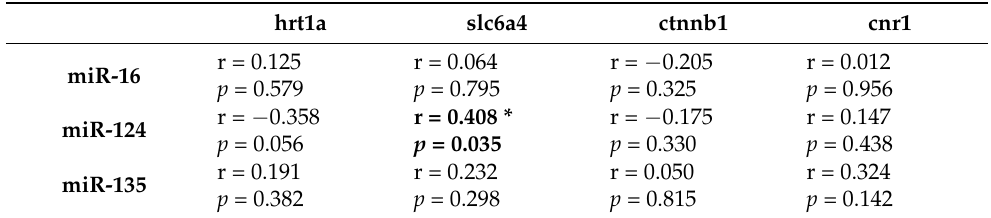
Table 4. Pearson correlation coefficients between miRNA levels and genes in the raphe nucleus in rats exposed to UCMS and CBD.